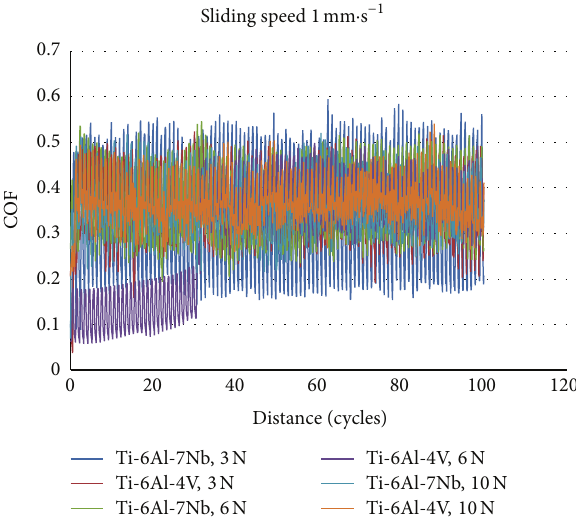
Figure 9: Friction coefficient of Ti-6Al-7Nb alloy versus sliding distance at tow sliding speed (15 and 25 mm ⋅ s −1 ).